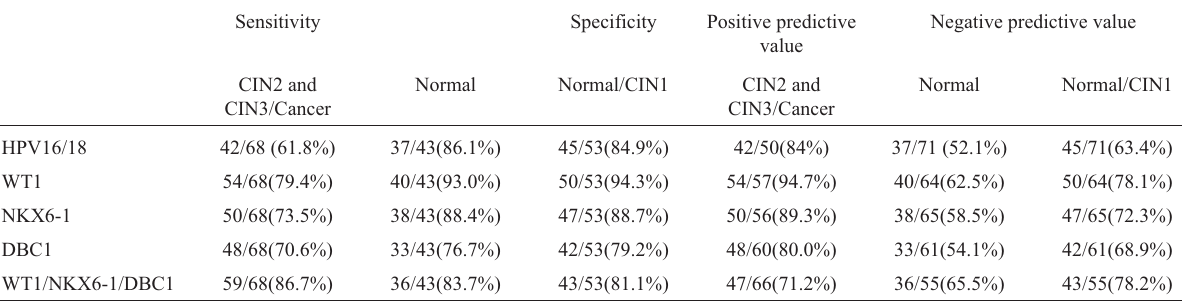
Table 8 - Sensitivity and PPV to detect CIN2, CIN3 or cancer, and NPV and specificity for normal or